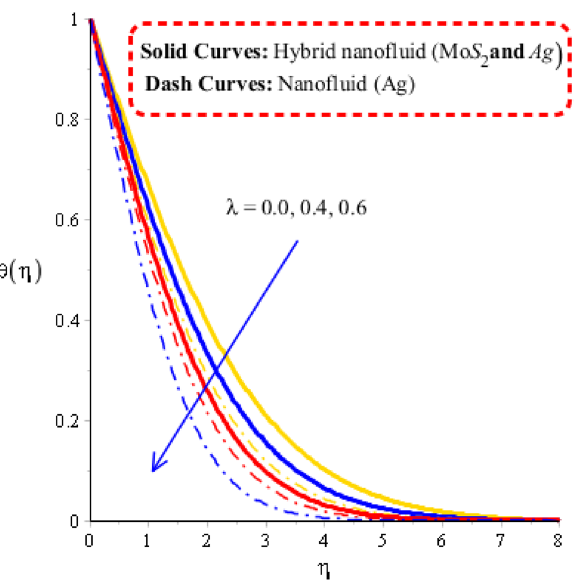
Figure 6. Temperature curves against Hs when ε δ = 1.2, ϕ 1 = 0.003, ϕ 1 = 0.075.